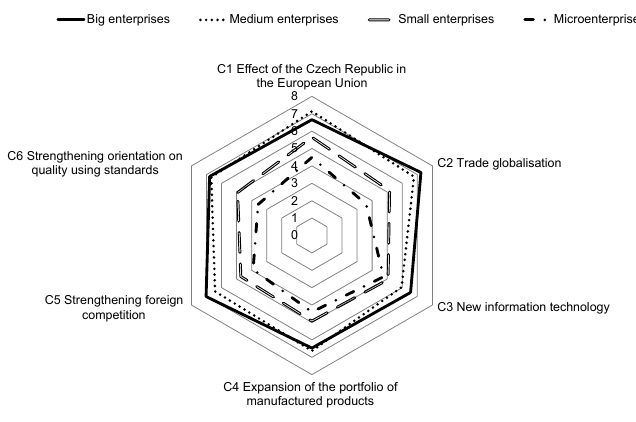
Fig. 1 – Rating of the impact of changes of the business environment on the supplier-customer relationships of engineering enterprises (rating 1 = negligible impact, 10 = extreme impact) Source: Survey questionnaire (2017), n =